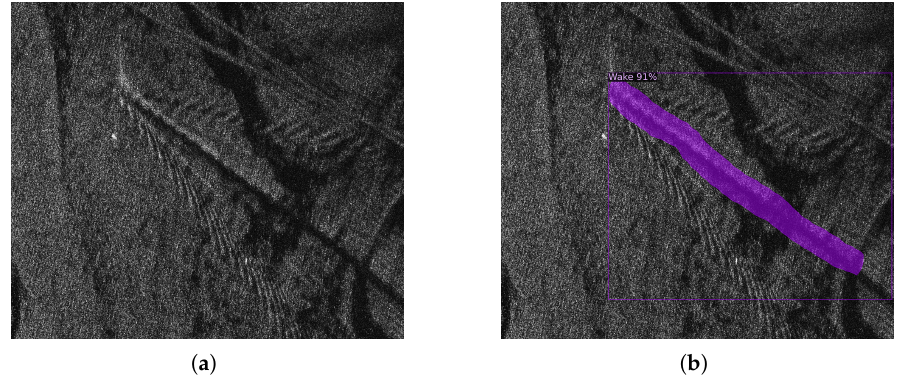
Figure 12. Subset (1825 × 1563 pixels) of the CSK product (CSKS1_SCS_B_HI_0B_HH_RA_SF_ 20080630045711_20080630045718) gathered in HH polarization over the Gulf of Naples, Italy, on 30 June 2008 (Azimuth-Slant Range coordinates). ( a ) Reference image, ( b ) Segmentation